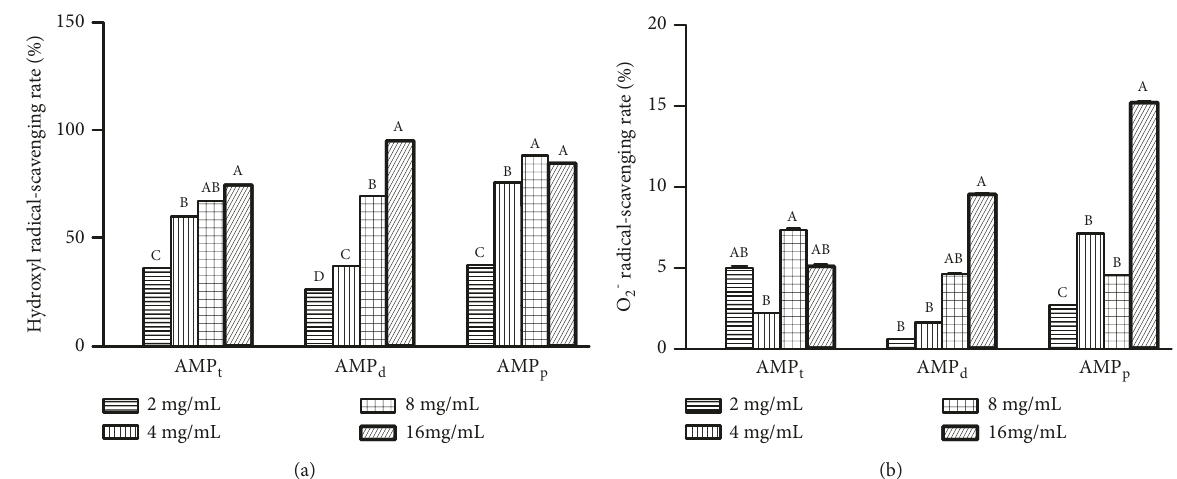
Figure 2: The antioxidant activity of AMP t , AMP d , and AMP p at 2, 4, 8, and 16mg/mL. AMP t , total AMP; AMP d , protein-deleting AMP; AMP p , purified AMP. Bars without the same superscripts (A–D) differ significantly (P < 0.05).